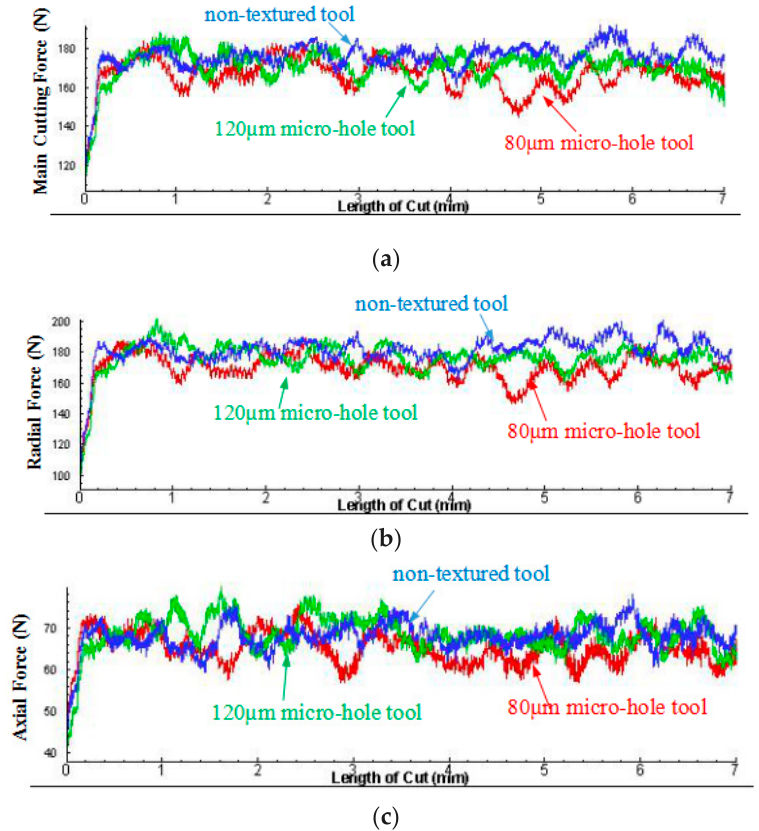
Figure 5. The comparison of cutting force of different PCBN tools: ( a ) the main cutting force; ( b ) the radial force; ( c ) the axial force.